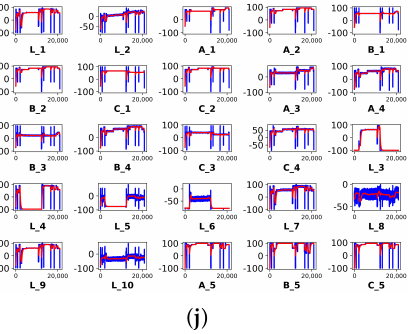
Figure 7. Time series visualization of ( a ) C17-1, ( b ) C17-2, ( c ) C8, ( d ) C9, ( e ) C11, ( f ) C13-1, ( g ) C13-2, ( h ) C14, ( i ) C15, and ( j ) C16.